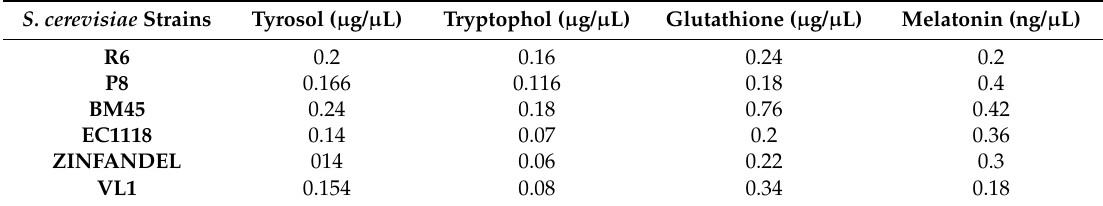
Table 3. Concentrations of bioactive compounds in experimental wines, after the treatment to remove ethanol, and used in ex-vivo